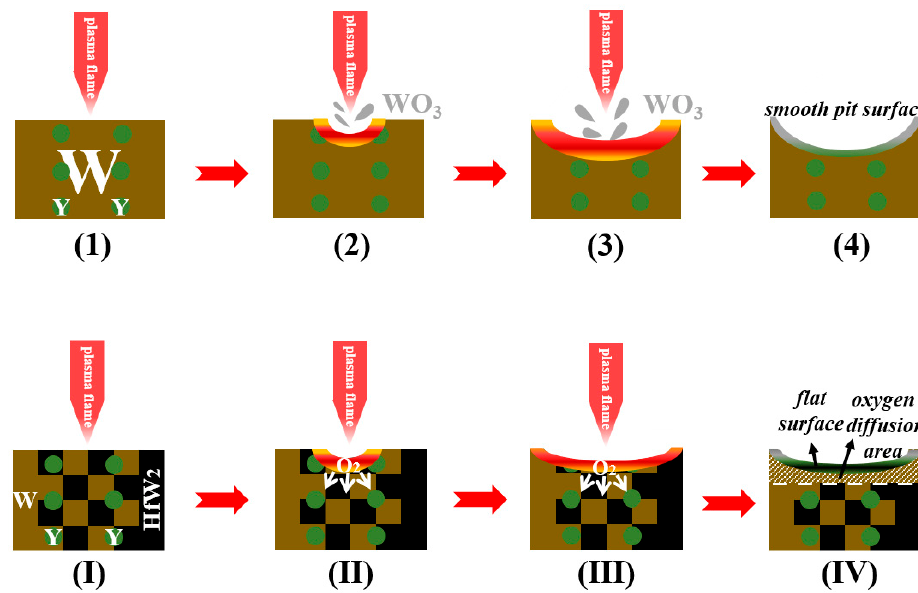
Figure 7. Ablation mechanism of ( 1 – 4 ) W-1.5 Y and ( I – IV ) W-1.5 Y-x Hf.